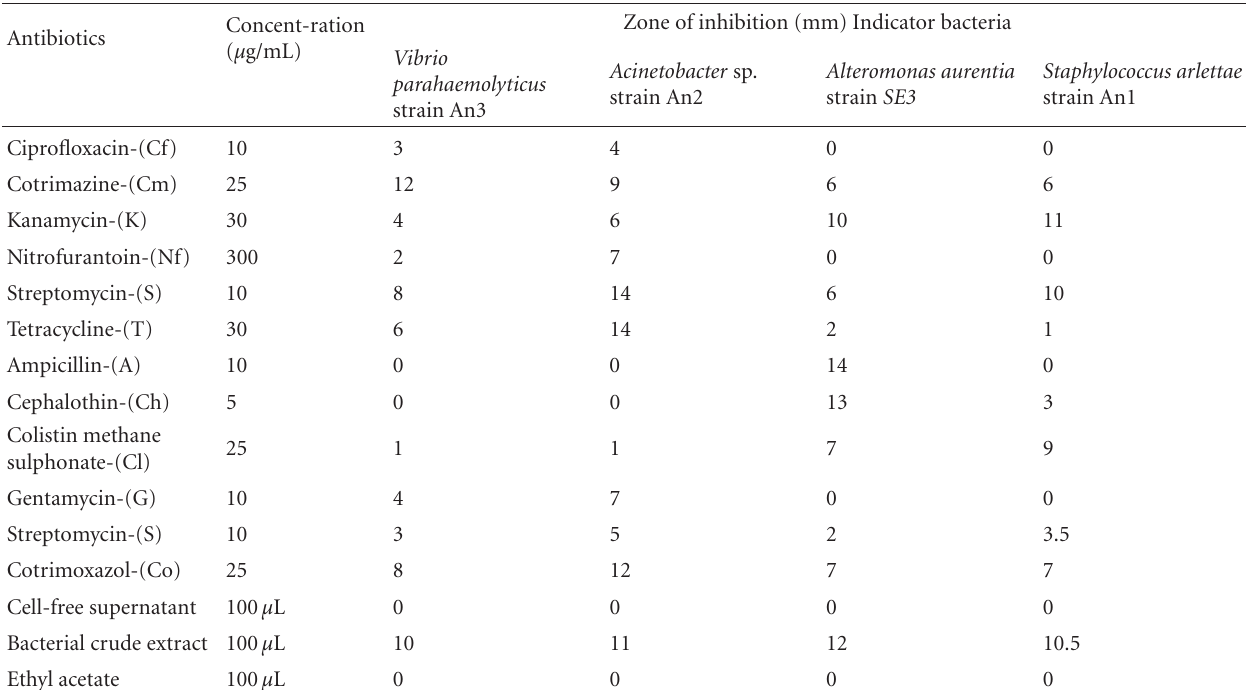
Table 1: Comparison of antibacterial activity of Aeromonas hydrophila strain An4 with commonly used antibiotics on indicator bacterial